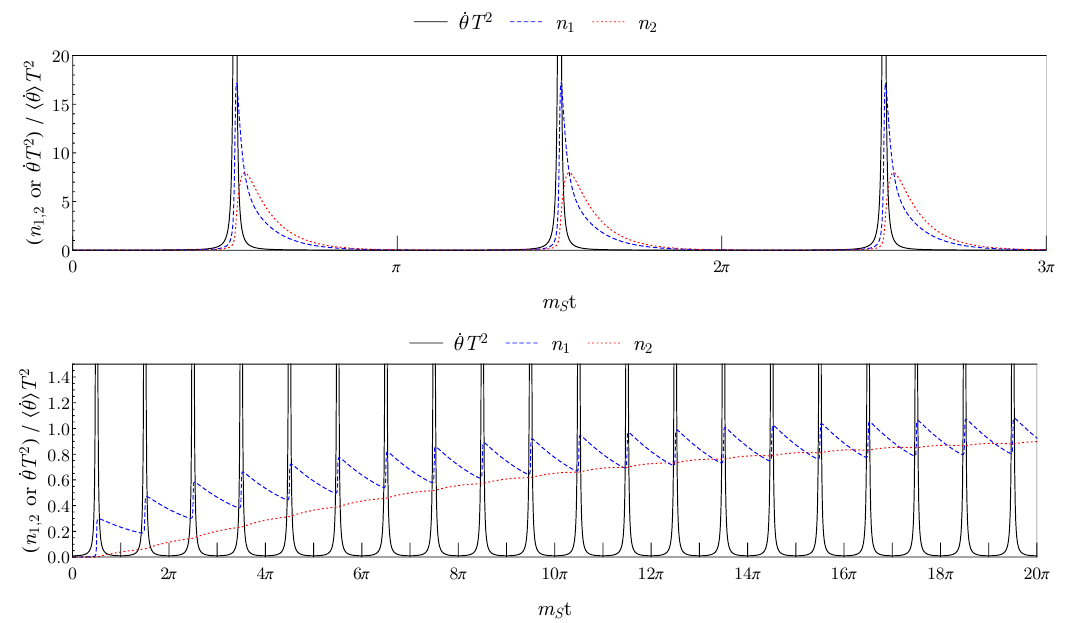
Figure 8 . The evolution of asymmetries. In the upper panel, m S (cid:28) Γ 1 , 2 (cid:28) m S /(cid:15) , while in the lower panel Γ 1 , 2 (cid:28) m S (cid:28) m S /(cid:15)